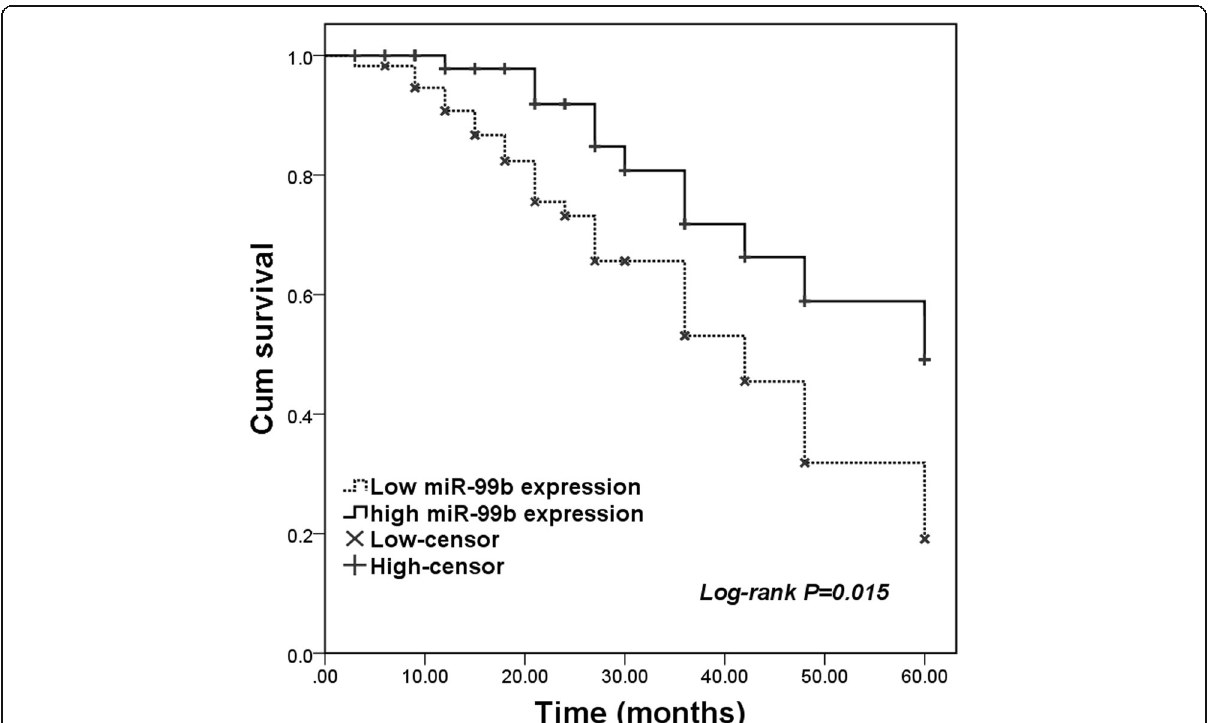
Fig. 2 Kaplan-Meier survival curves in the patients with OS. Patients with low expression of miR-99b had shorter survival time than those with high miR-99b expression. Log-rank P = 0.015